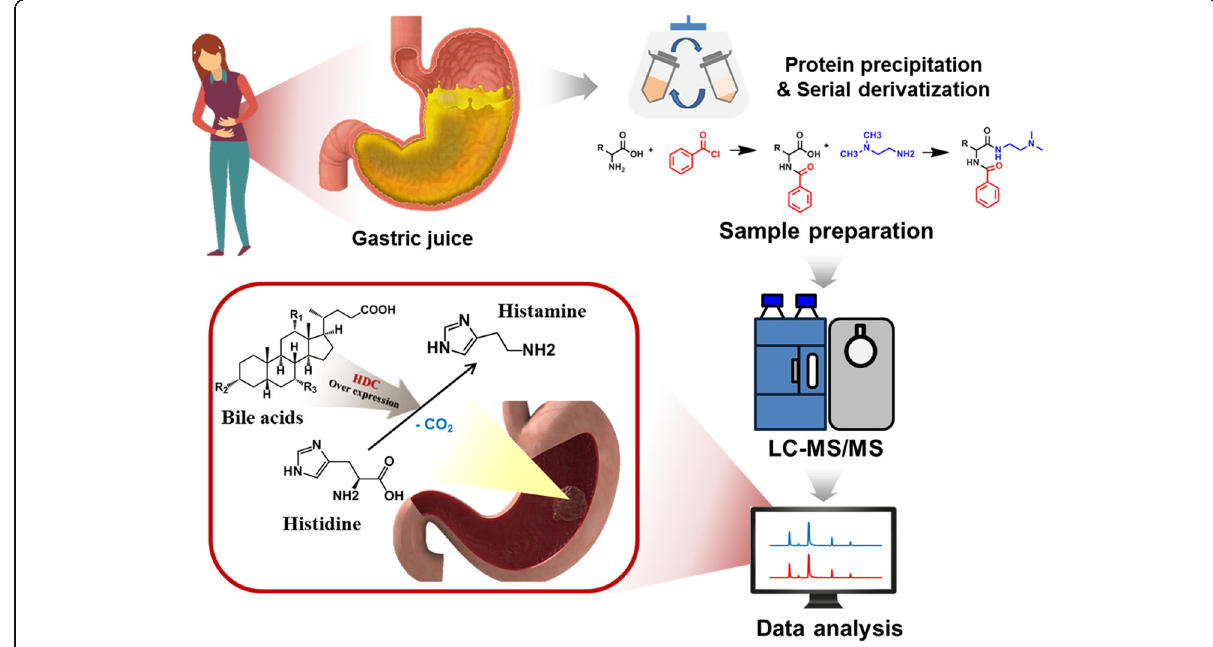
Fig. 1 Analytical procedure for profiling of HIST, His, and BAs in gastric